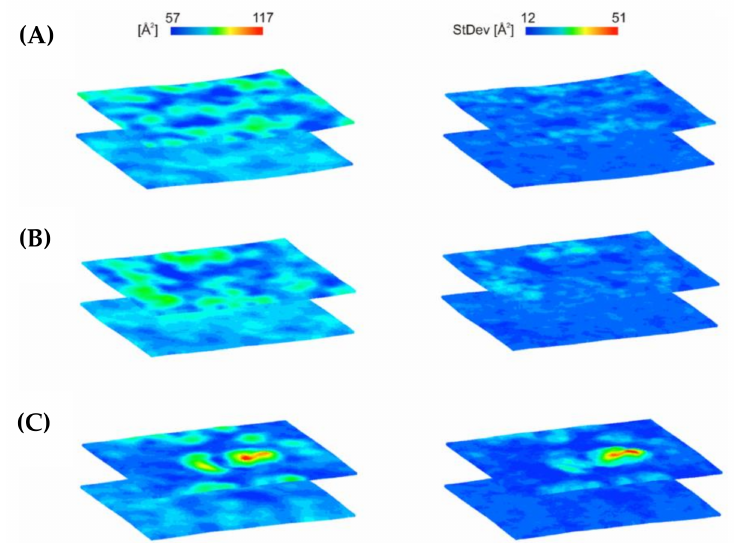
Figure 8. Local area per lipid (APL) of the 1:3 POPE:POPG bilayer averaged over last 100 ns of MD simulations for ( A ) C5-DK5, ( B ) C12-DK5 and ( C ) C12-CAR-PEG-DK5. Phosphate beads of the lipid headgroups were considered for calculations.